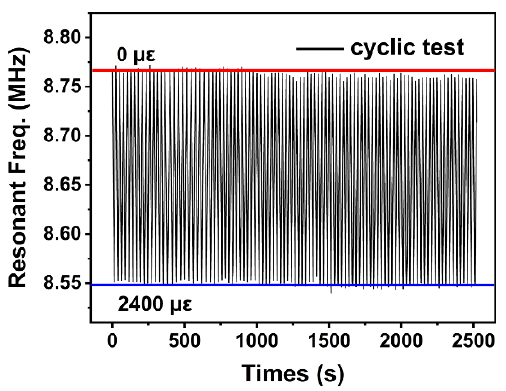
Figure 6. Frequency shift under cyclic bending strain from zero to 2400 με for 98 cycles (2500 s ), showing excellent device stability.